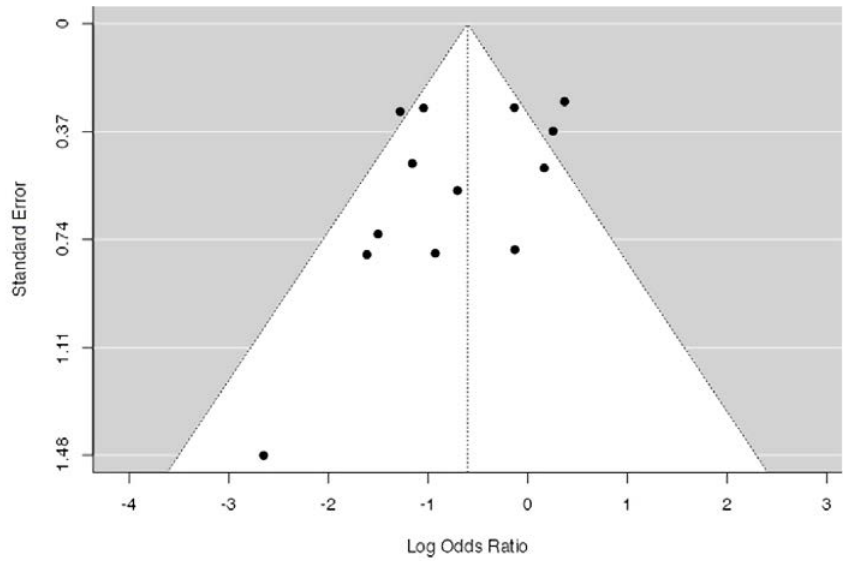
Figure 4. Funnel plot illustrating the publication bias results of the included studies.